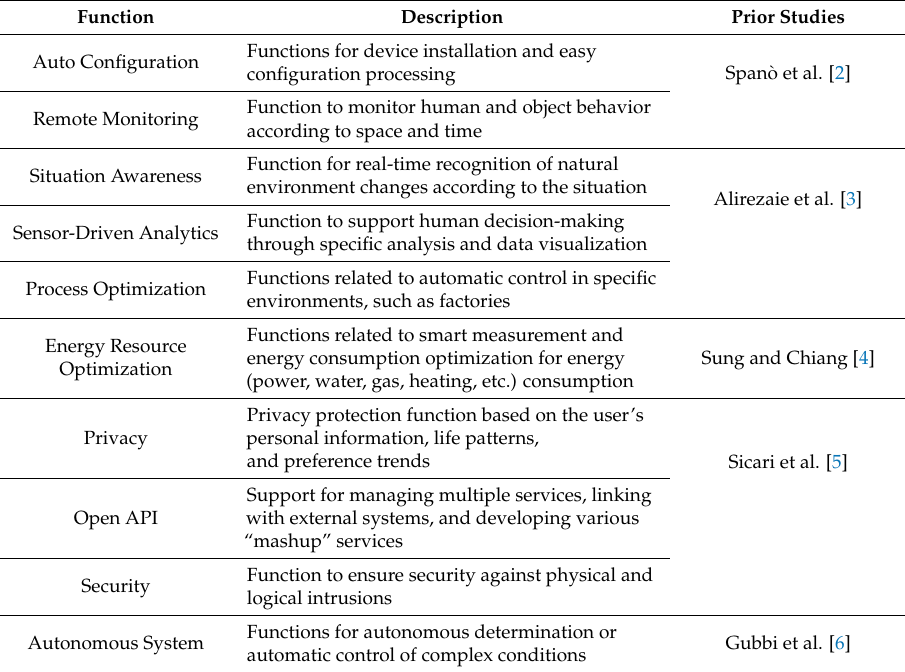
Table 1. Nine key features of the home IoT